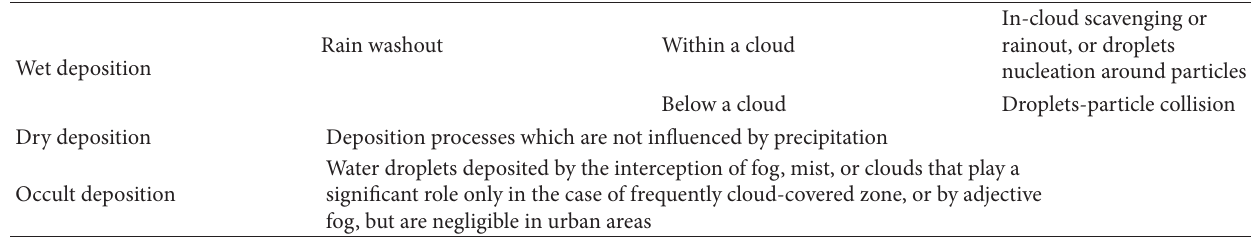
Table 1: Mechanisms of aerosol deposition